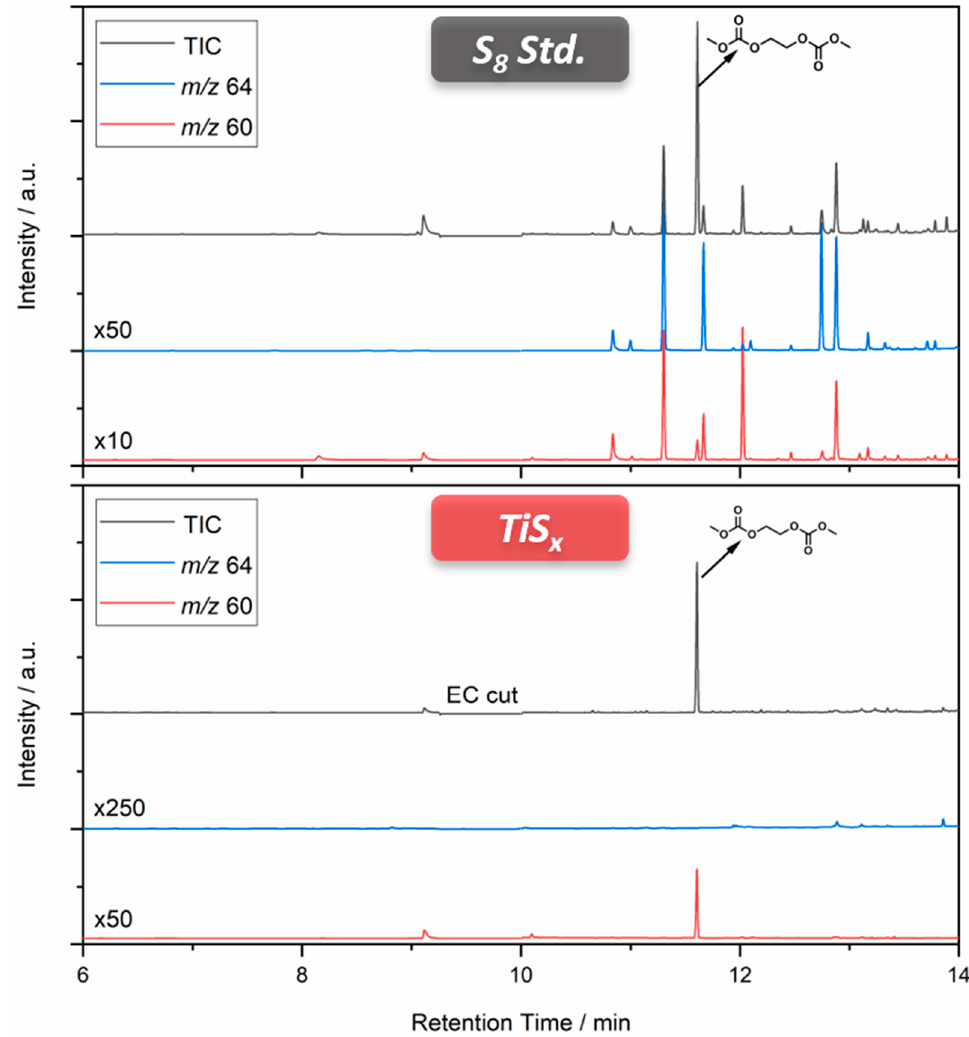
Figure 6. TICs and EICs connected to the carbonate-based electrolytes regained from cells with sulfur/titanium sulfide cathodes.